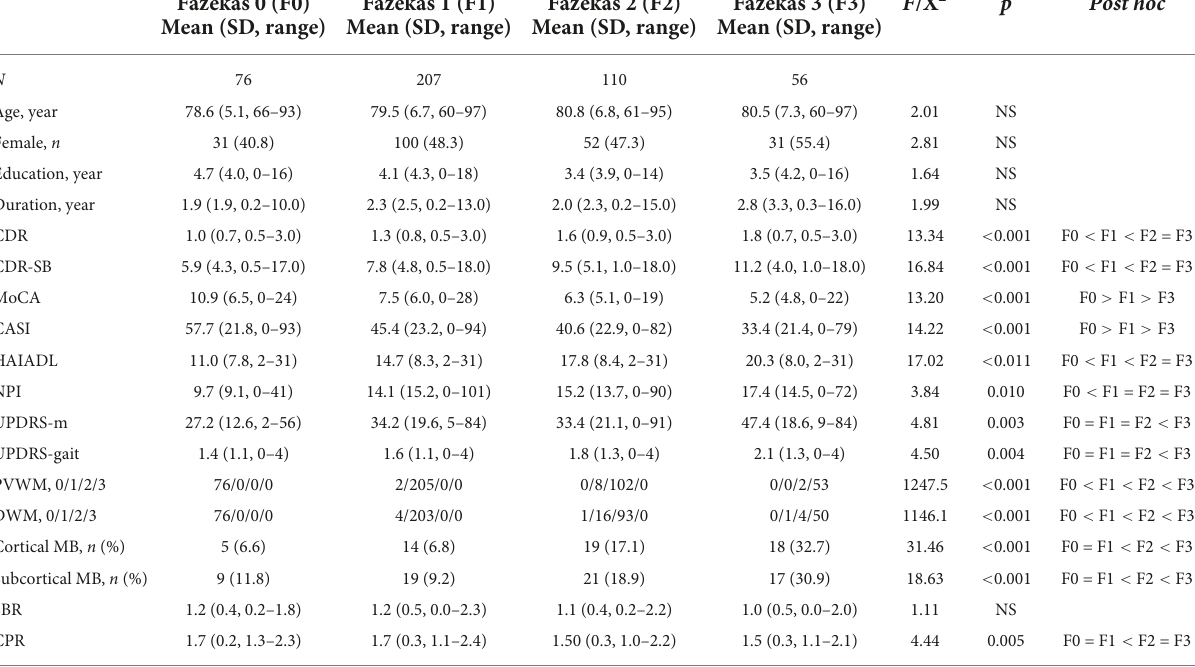
TABLE 1 Comparison of demographical characteristics among different Fazekas groups.